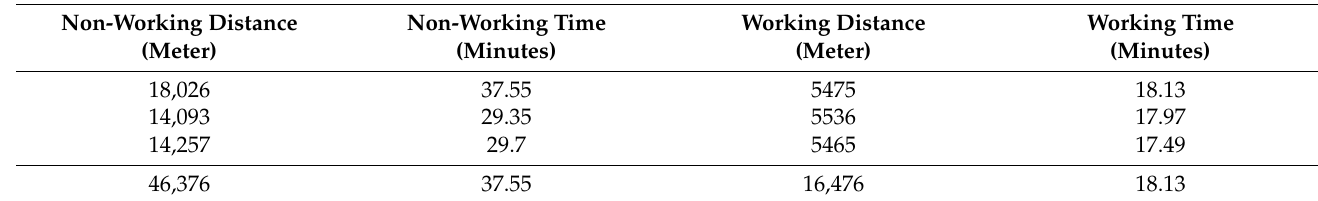
Solution (1st Scenario)